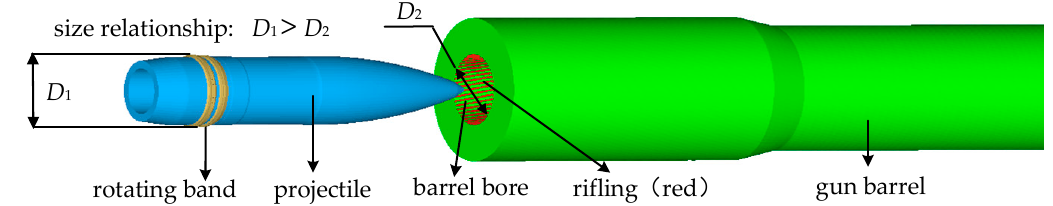
Figure 7. Representation of size relationship of rotating band diameter and barrel bore diameter.